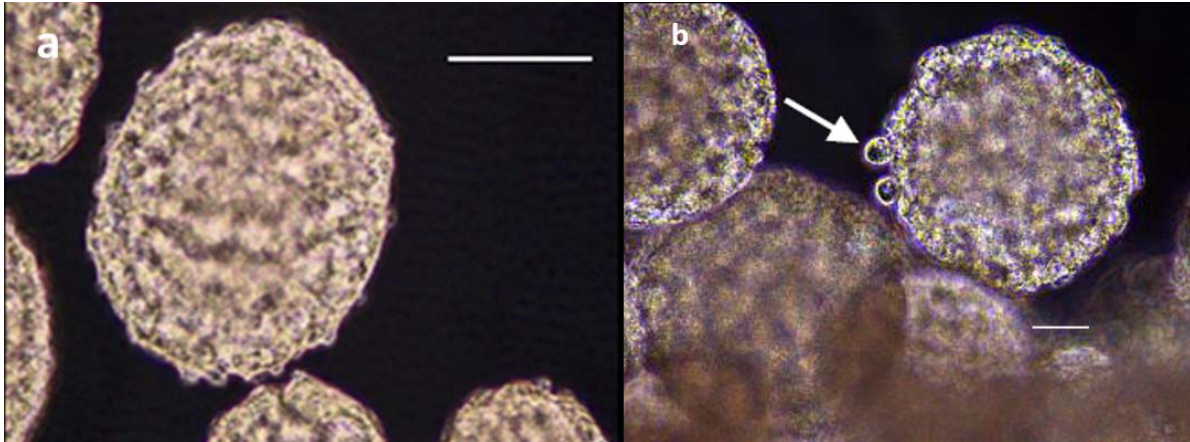
Figure 8. Tick cell growth and aggregation with gelatinous beads. ( a ) Light micrograph of gelatinous microcarrier bead (Cultispher-G ® ) that reportedly has an irregular outer surface with flow-through perforations providing external and internal cell binding locations, which was used to grow BmVIII-SCC cells in rotating cell culture system bioreactor; Scale bar = 12.5 µ m. ( b ) Lateral light microscopic view of multiple BmVIII-SCC—gelatinous bead aggregates on day 85 p.i. Membrane-bound and translucent large cell-like structures appeared to bud from bead surfaces covered with cells (arrow). View: 400 × . Scale bar = 25 µ